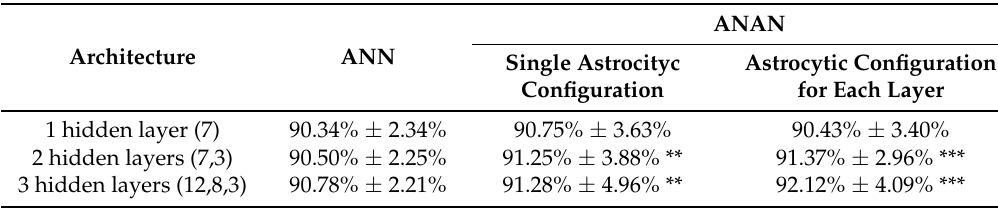
Table 1. Comparative study of the classification accuracy (test values). The values described in the table refer to average performance (100 different runs) and the statistically significance (* p < 0.05, ** p < 0.01 and *** p < 0.001). The asteriscs compare ANAN to ANN. The architecture shows the number of neurons used on each hidden